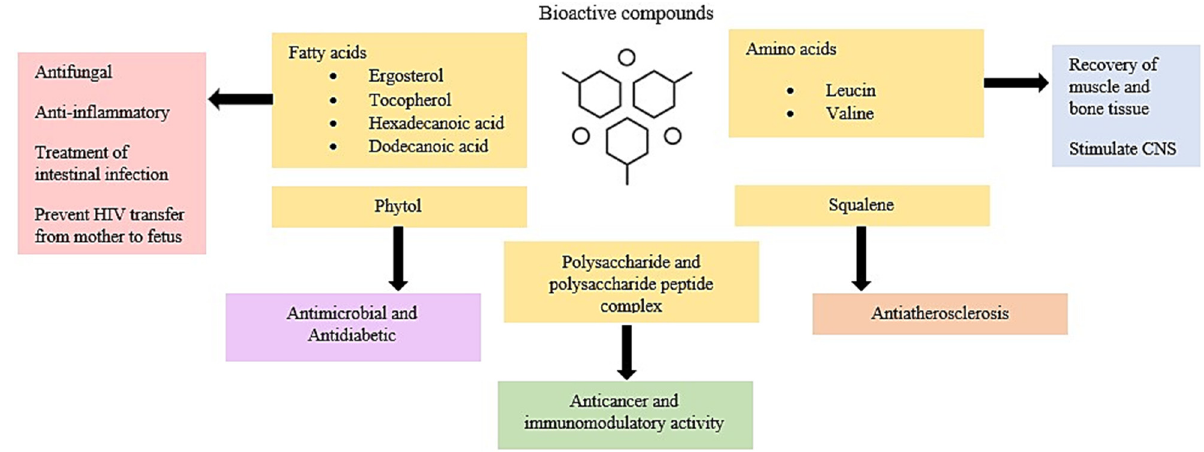
Figure 2. Bioactive compounds in milky mushrooms and their applications. CNS: central nervous system.